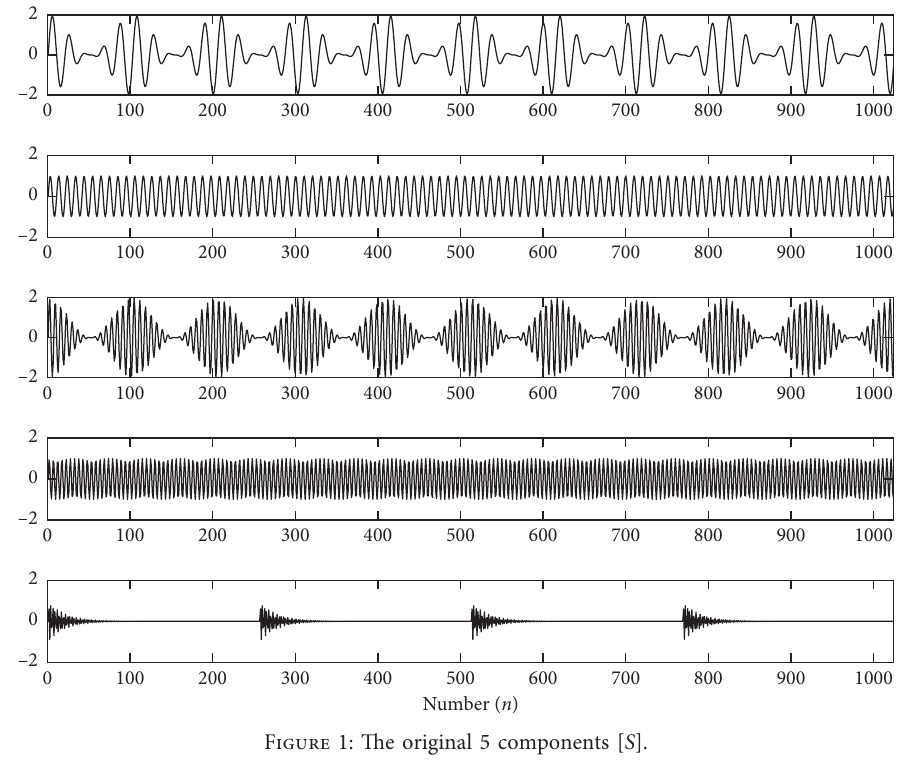
Figure 1: The original 5 components [ S ].